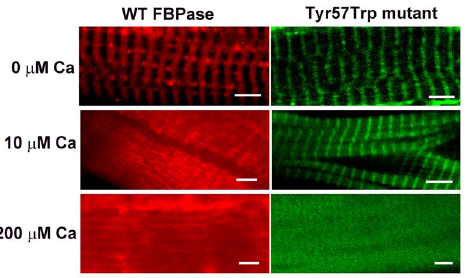
Figure 4. Relationship of loop 52–72 to the three divalent metal binding sites. In the engaged conformation of the loop (purple), Asp68 and Glu69 are in the close proximity to the catalytic metal binding site 3 (green sphere marked as ‘‘3’’). The structure of human muscle FBPase with the loop in its engaged state was constructed on the basis of 1CNQ [23] as described by Rakus at al [11]. The image was drawn with Accelrys Discovery Studio software (Accelrys H